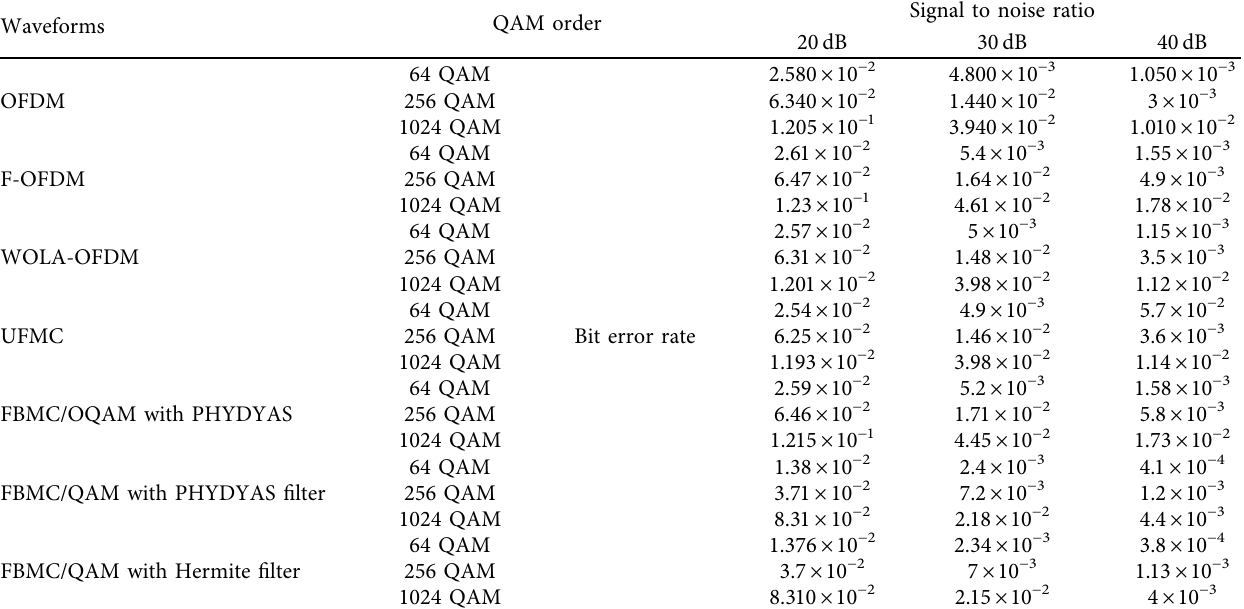
Table 3: Bit error rate performance of multicarrier modulation techniques with 64 QAM, 256 QAM, and 1024 QAM for Vehicular A channel